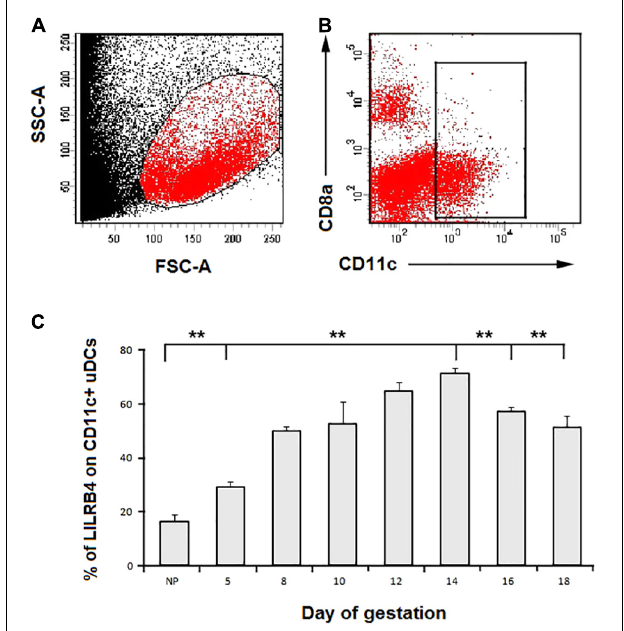
FIGURE 2 | Dynamic expression of LILRB4 on uterine DCs. (A) Decidual lymphocytes were gated in the appropriate location for flow cytometric analyses. (B) Uterine DCs were gated by CD11c expression. (C) Flow cytometry analyses of LILRB4 dynamic expression on CD11c + uterine DCs were performed using non-pregnant mice and normal pregnant mice at day of gestation (Gd) 5, 8, 10, 12, 14, 16, 18, respectively. Data are shown as means ± SD for 10 pregnant mice and differences were identified using unpaired t -tests ( ∗ p < 0.05, ∗∗ p <